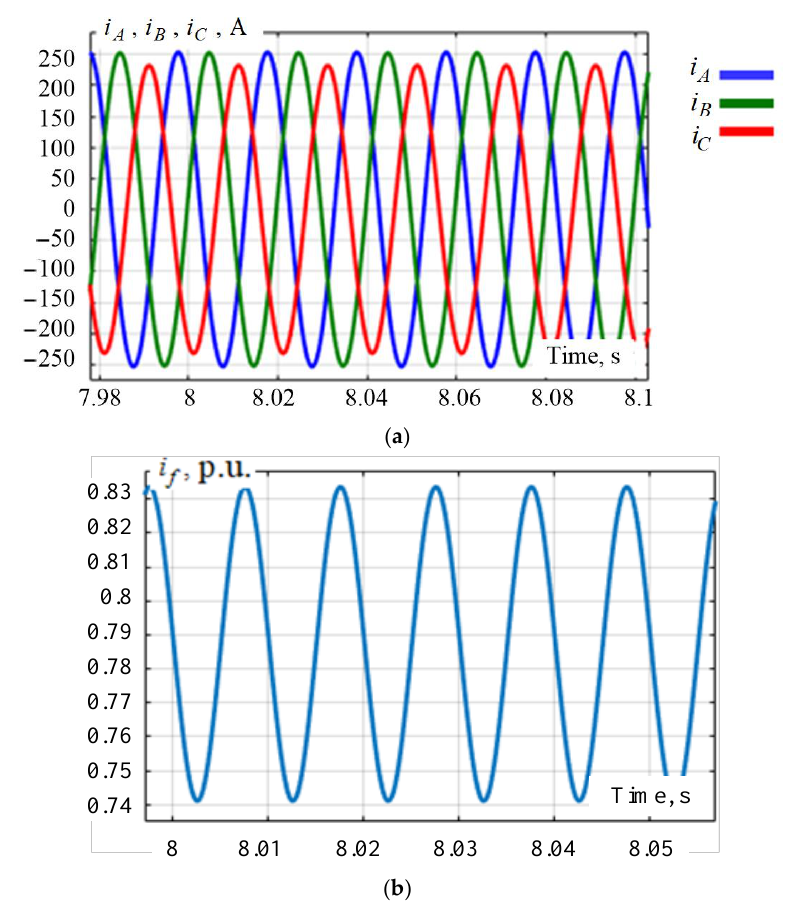
Figure 3. Waveforms of stator currents ( a ) and rotor currents ( b ) of the generator at I k 2 = 11.96%. Table 2. Experimental data for the case of the generator model in MATLAB serving a unbalanced load.